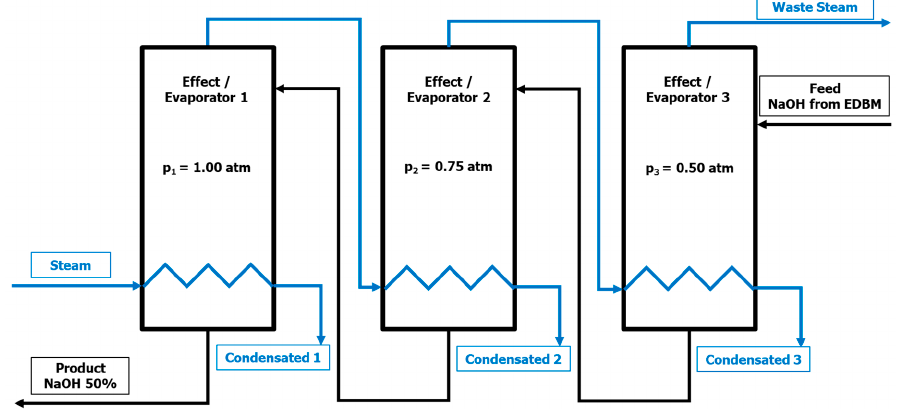
Figure 1. Flow diagram of the triple effect evaporation for the NaOH concentration. The heat exchange in an evaporator can be produced isothermally (constant tempera- ture) or isobarically (constant pressure), in this simulation, the constant pressure has been selected, with pressures of 1.00 atm, 0.75 atm, and 0.50 atm for the first, second, and third effects,